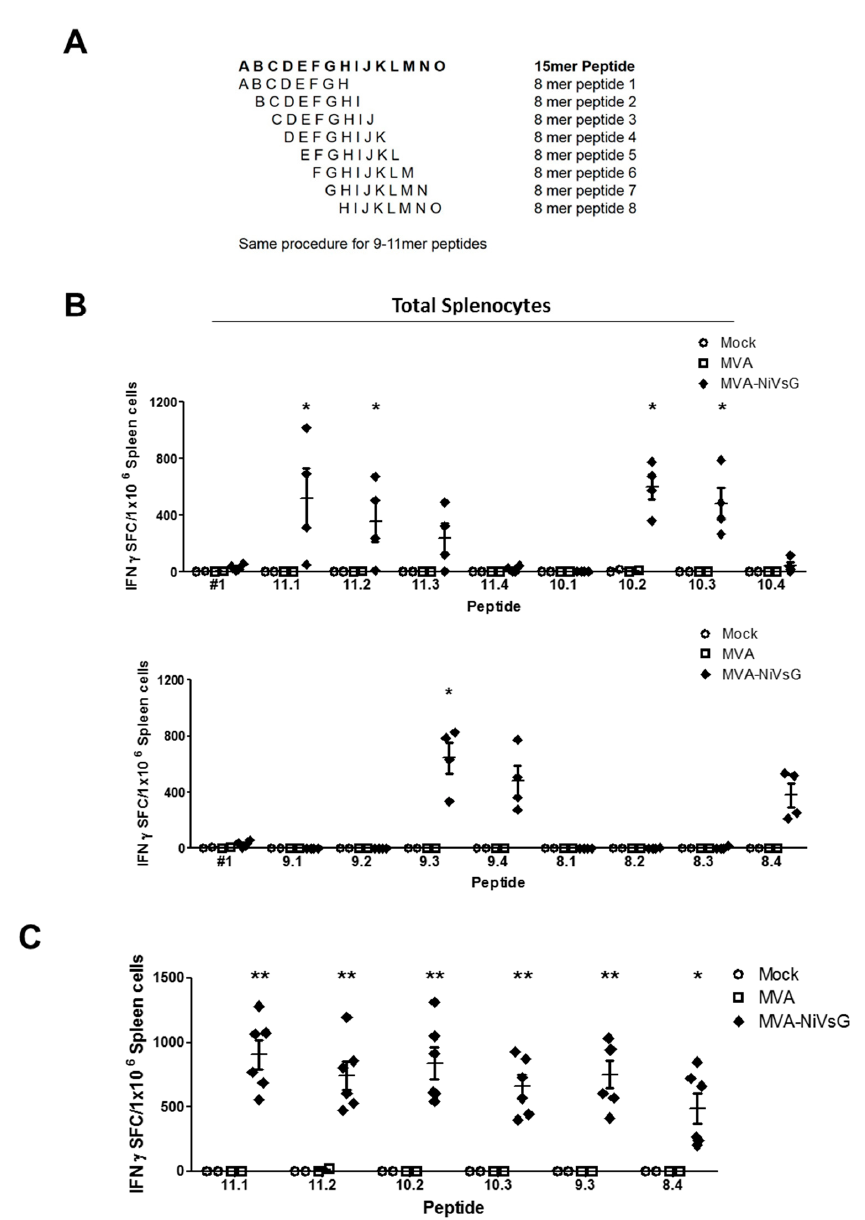
Figure 4. Identification of H2-b-restricted T cell epitopes in the NiV-G protein. Groups of IFNAR − / − mice ( n = 2–4) were immunized twice with MVA–NiVsG, MVA, or saline (mock) via the i.p. or intramuscular (i.m.) routes over a 21 day period. Spleens were collected and single cells suspensions were prepared 8 days after the final immunization. Total splenocytes were restimulated and measured by ELISPOT assay. ( A ) Schematic overview of 8–11mer overlapping peptide generation. The amino acid sequence of the positive 15mer peptide, #1, served to generate peptides with every possible 8–11mer sequence. Sequences were selected based on H2-b binding prediction results obtained from the SYFPEITHI database. ( B ) Mapping of H2-b-restricted 8–11mer overlapping peptides spanning the positive 15mer peptide #1 (YTRSTDNQAVIKDAL). Graphs show IFN- γ SFC of total splenocytes from i.p. immunized mice restimulated with peptide #1 and 8–11mer overlapping peptides. ( C ) Confirmation of positive H2-b-restricted peptides of NiV-G. Graph shows IFN- γ SFC of total splenocytes from i.m. immunized mice restimulated with the six most positive 8–11mer peptides (11.1, 11.2, 10.2, 10.3, 9.3, 8.4). Differences between groups were analyzed by one-way ANOVA. Asterisks represent statistically significant overall di ff erences for a specific peptide. * p < 0.05, ** p <